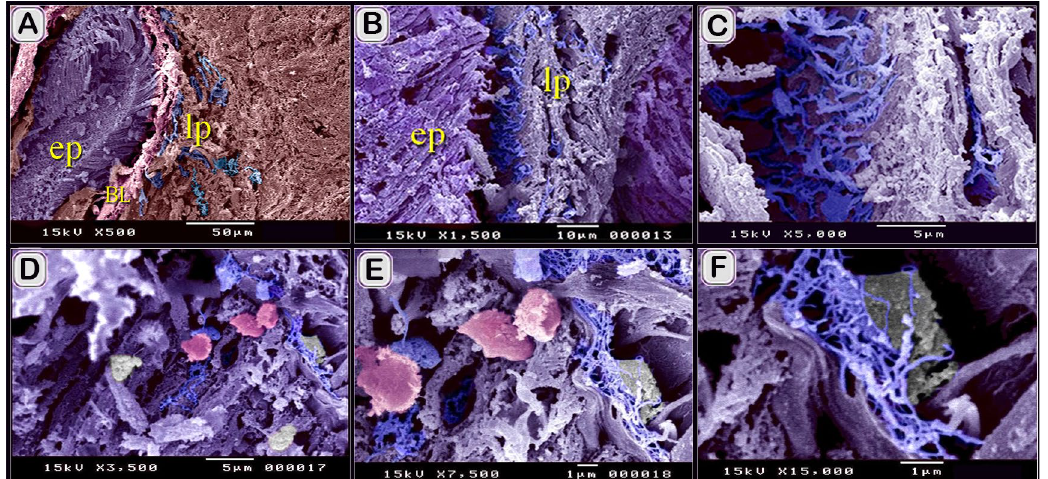
Figure 13. Scanned mucosal TC. ( A ) general view of the scanned sample of the intestinal blub. Note the epithelium (ep, violet color), lamina propria (lp), muscle (brown color). Basal lamina (Bl, pink color), TCs (blue colored). ( B , C ) sub epithelial TC sheet (blue colored). Note the epithelium (ep, violet color), lamina propria (lp). ( D – F ) TCs (arrowheads) in the lamina propria make contact with rodlet cells (pink colored) within the epithelium, were bear-shaped, and the capsules were